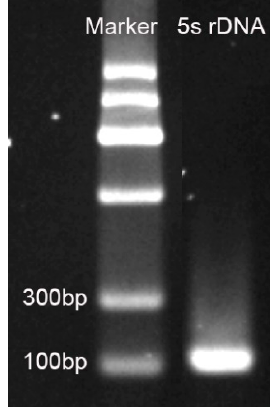
Figure 4 . 5S rDNA homologous sequence amplification results.